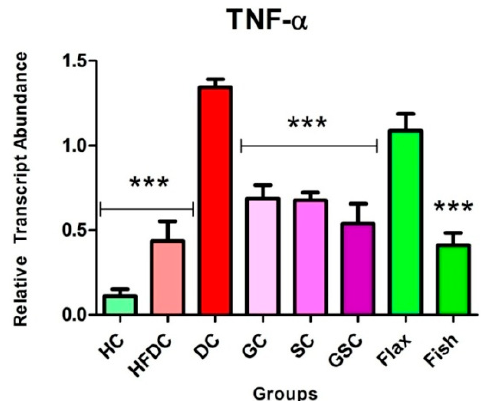
Figure 10. Expression of TNF- α in experimental groups. Results are represented as Mean ± SE ( n = 3 for each group). *** p ≤ 0.001, when compared with the DC group (Dunnett’s Multiple Comparisons Test). HC: Healthy control, HFDC: High fat diet control, DC: Diabetic control group-treated STZ and TNF- α : Tumor necrosis factor-alpha.